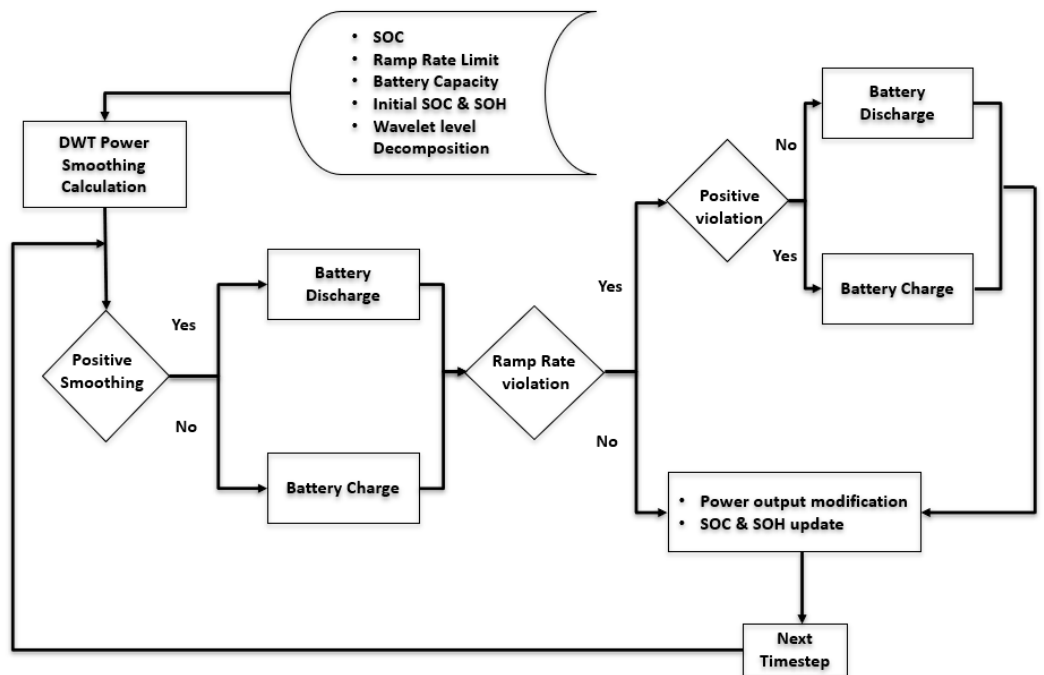
Figure 8. Schematic flowchart of the developed power smoothing algorithm. Table 2. Smoothing algorithm inputs.